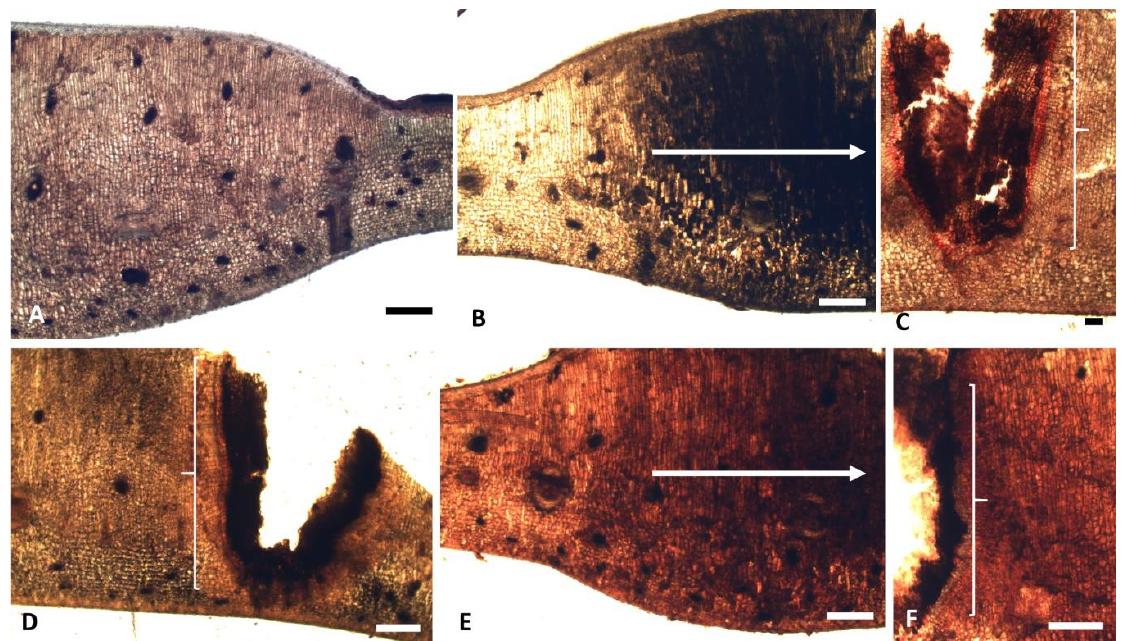
Figure 5. C. fluminensis . Galled leaves of male individuals ( A – F ). TS exhibiting histochemical analyses. ( A ) Blank section. ( B ) Test with FeCl3 exhibiting phenolic compounds (dark precipitate). Note the abundance of phenolics towards the larval chamber (arrow), notably in the palisade and spongy parenchyma. ( C ) Test with Sudan IV revealing lipids in the adjacent layers of the nutritive tissue (}) but rare in the mesophyll. ( D ) Test with lugol, revealing starch (dark precipitate) in the nutritive tissue and adjacent layers ({). ( E , F ) Test with Fehling and Benedict reagents showing reducing sugars (brownish precipitate). Note the abundance in the mesophyll towards the larval chamber (}) (arrow). Bars: ( A – F ) = 200 µm.